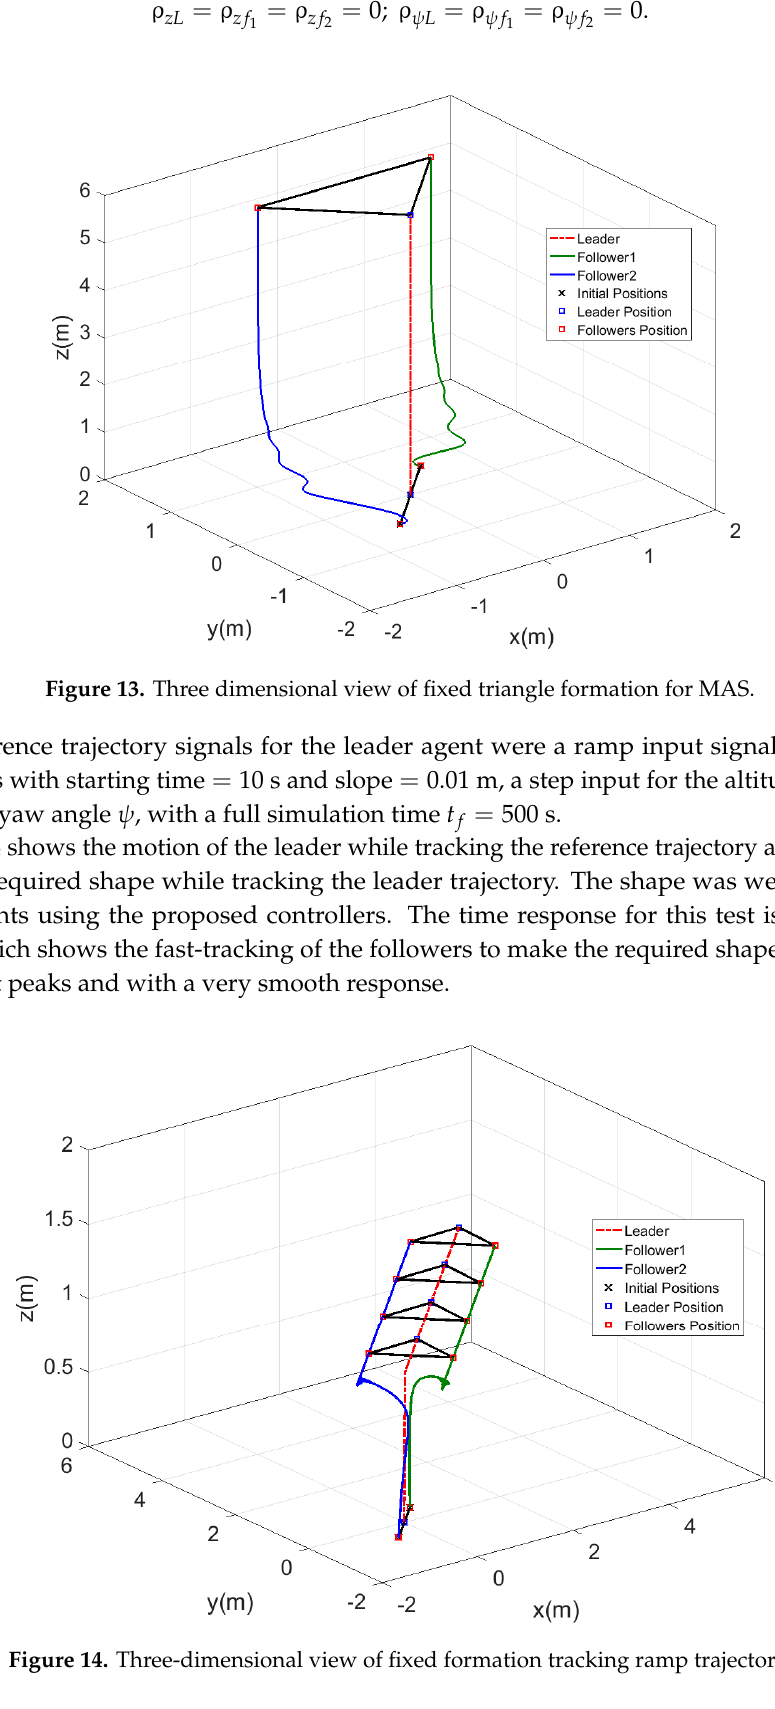
Figure 12. Time response of fixed triangle formation for MAS.